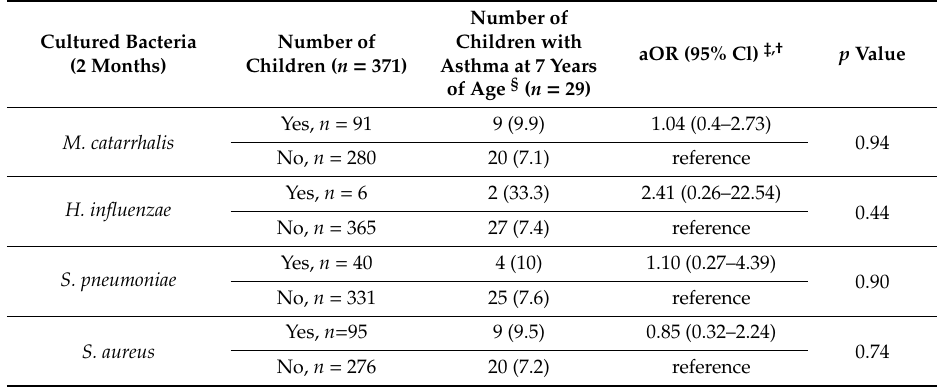
Table 3. The e ff ect of colonization of nasopharyngeal bacteria at 2 months and 13 months of age on development of asthma by 7 years of